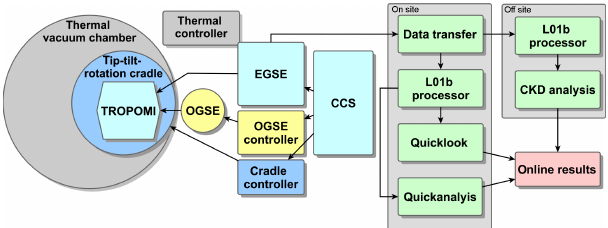
Figure 4. Calibration facilities. The instrument TROPOMI is placed on a tip–tilt–rotation stage (“cradle”) inside a thermal vacuum chamber. The optical ground support equipment (OGSE), the cra- dle, and the electric ground support equipment (EGSE) are all com- manded from the the central checkout system (CCS). The measure- ment data and ancillary data from the cradle and OGSE are trans- ferred to an on-site server. Locally quick look and quick analysis is performed; the derivation of the CKD is performed off-site. Prelim- inary results and the quick look data are made available online for all parties